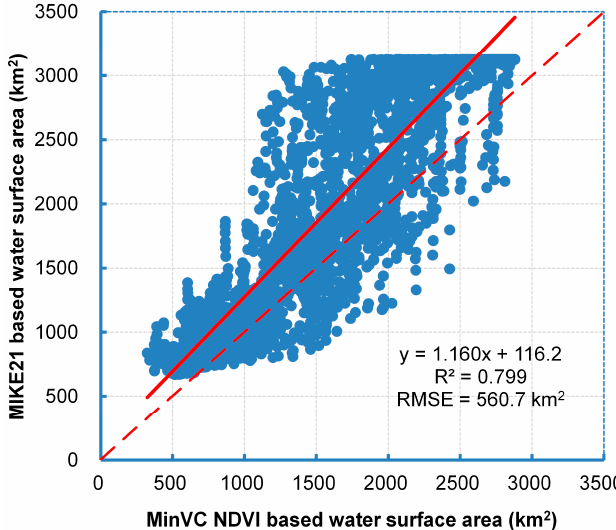
Figure 6. Comparison of the MinVC NDVI based and the MIKE21 hydrodynamic modeling based water surface area data (2003–2017).